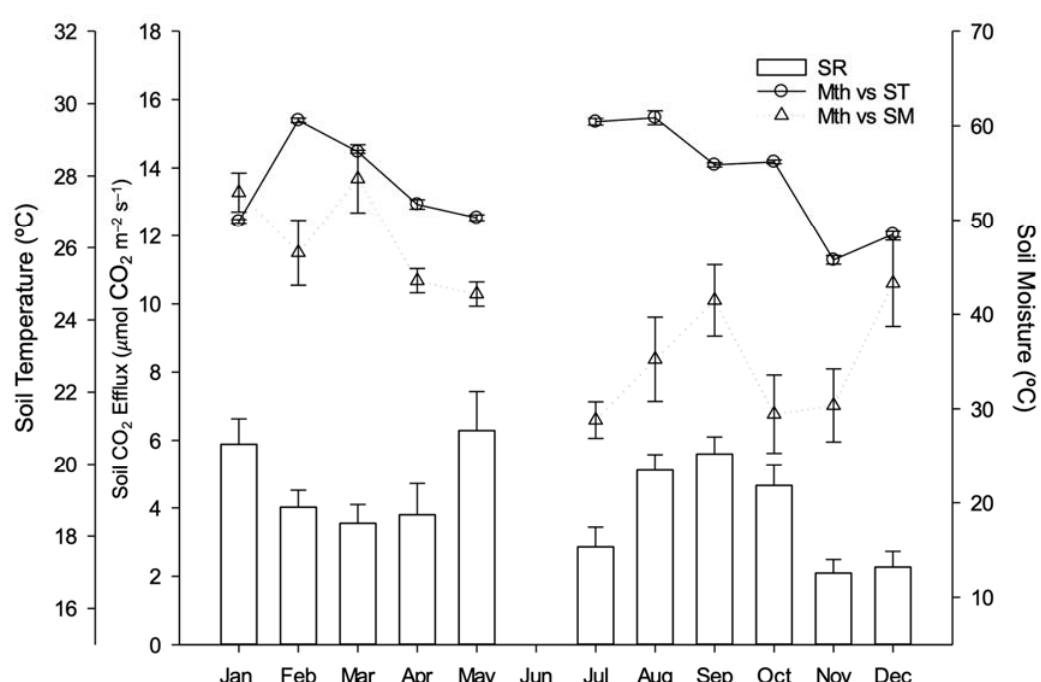
Figure 7. Monthly mean soil CO 2 efflux (SR), soil temperature (ST), and soil moisture (SM) with standard error bars.